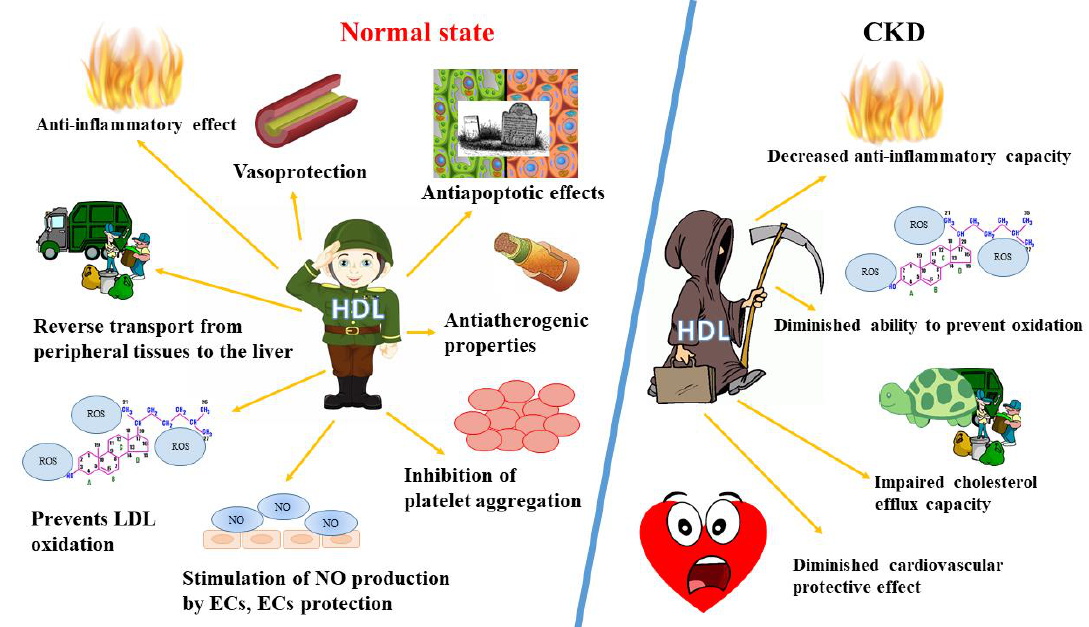
Figure 1. The summary of HDL functions in health and disease. CKD, chronic kidney disease; HDL, high-density lipoprotein cholesterol; LDL, low-density lipoprotein cholesterol; NO, nitric oxide; ECs, endothelial cells; ROS, reactive oxygen species.